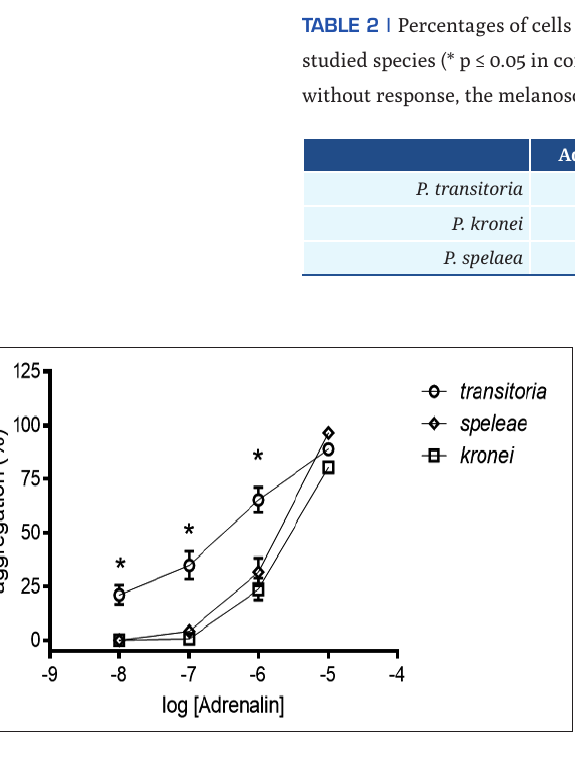
FIGURE 2 | Dose-response curves for MCH in melanophores of the species of Pimelodella . Each point is the mean ± SEM ( P. transitoria , n = 6, P. speleae , n = 7, and P. kronei , n = 8). Control – melanosomes fully